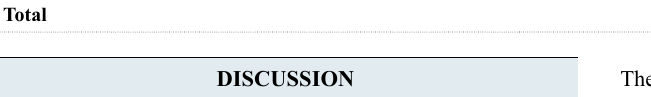
Table 3: Relationship of Pleural fluid cholesterol and/or protein level with the diagnosis on discharge Pleural fluid Cholesterol >60mg/dL and Protein >3g/dL